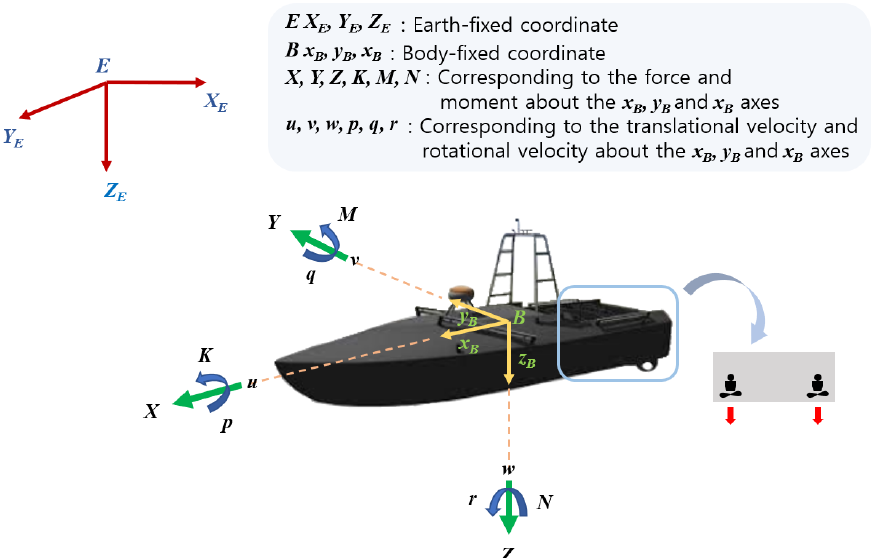
Figure 9. Schematic of the differential thrust of the unmanned surface vehicle (USV) and the definition of the motion variable.